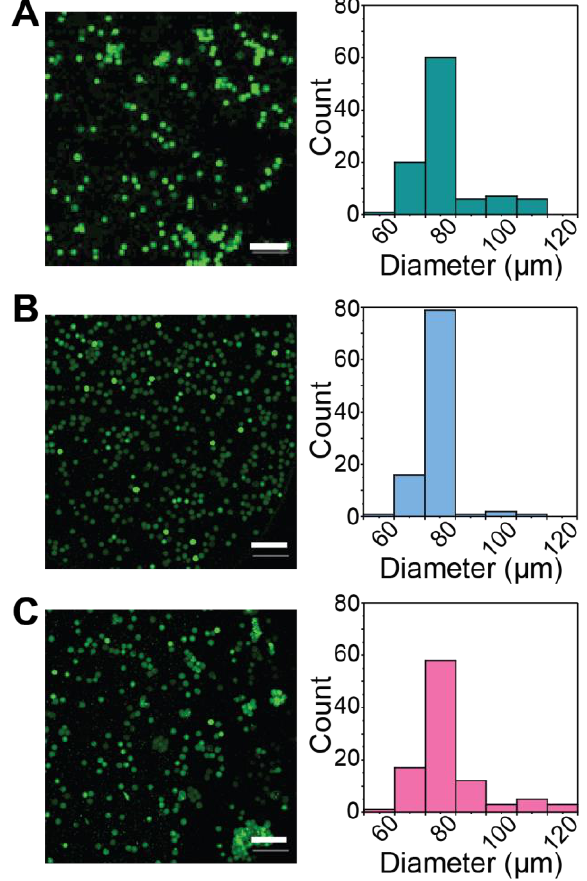
Figure 3. Formation of redox-responsive microgels. Microgels were formed by introducing PEG-4-arylSH:alkylSH and PEG-4-MI precursor components through opposite inlets with a buffer stream containing the desired protein of interest for encapsulation (BSA-AF488 here): homogeneous microgels were formed that contained ( A ) 90% (average diameter = 77.9 ± 12 µm), ( B ) 50% (average diameter = 73.9 ± 6 µm), or ( C ) 0% (average diameter = 76.7 ± 10 µm) degradable content. Scale bars = 500 µm. Representative images are shown on the left with histograms showing the distribution of diameters on the right.